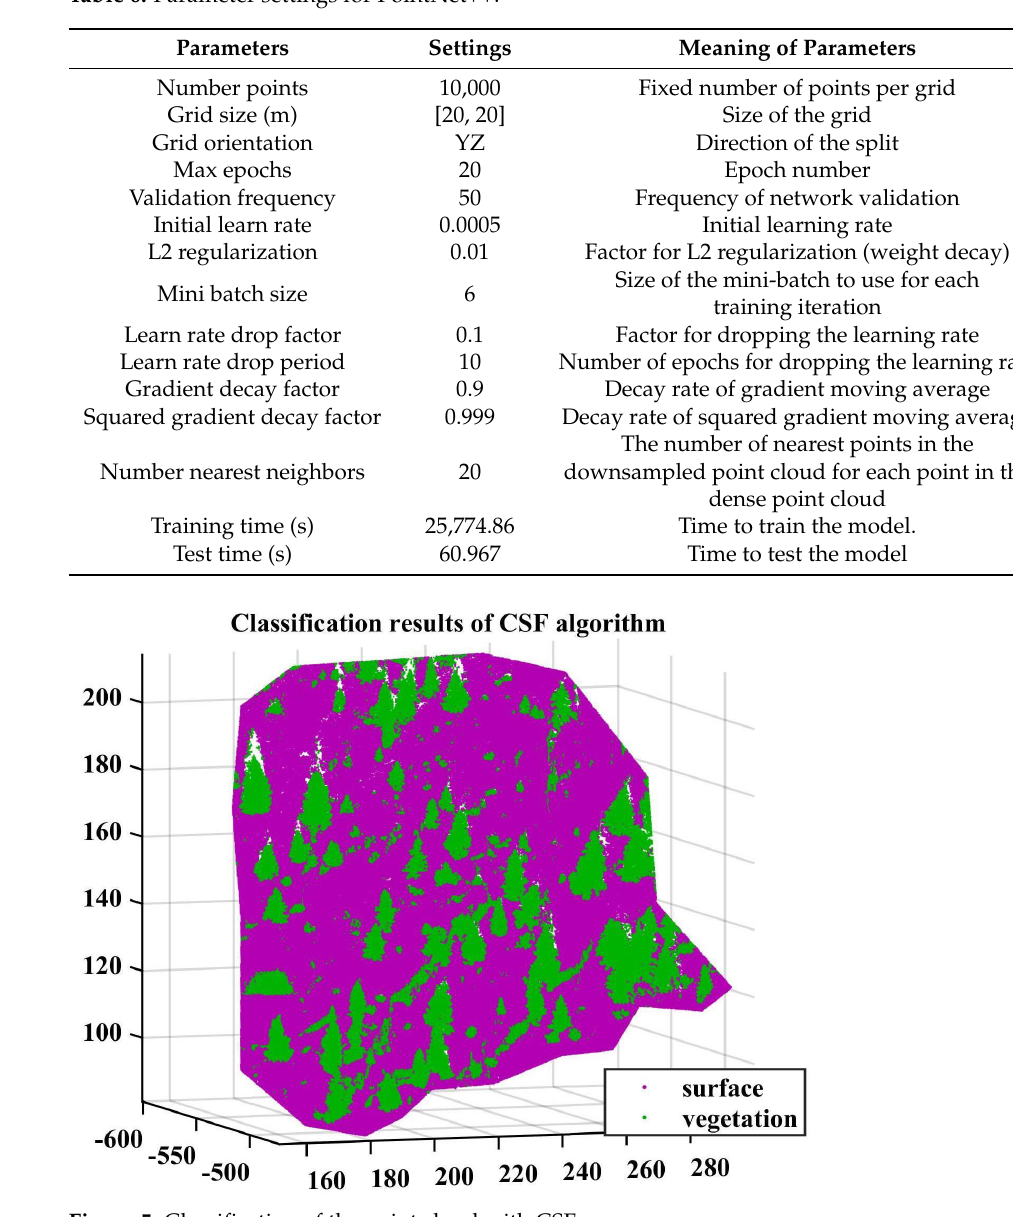
Figure 5. Classification of the point cloud with